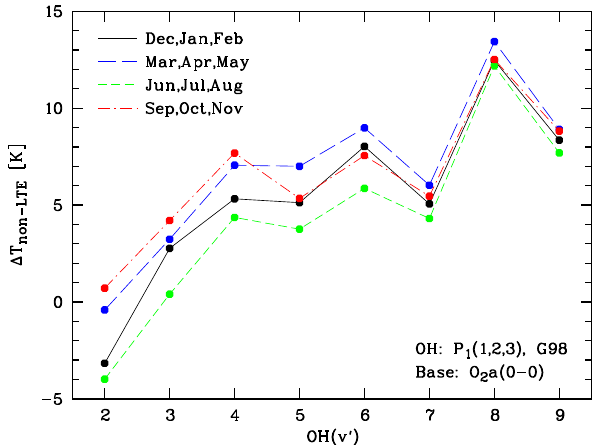
Figure 18. Same plot as Fig. 15 except for curves related to the four meteorological seasons instead of nighttime periods. The uncertain- ties for comparisons of (cid:49)T non-LTE for the different seasons and/or v (cid:48) are somewhat higher. 2K and more cannot be